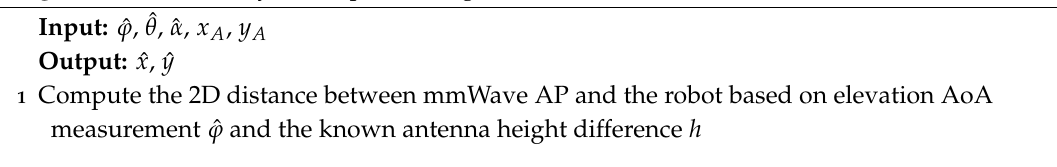
Algorithm 1: Geometry-based positioning